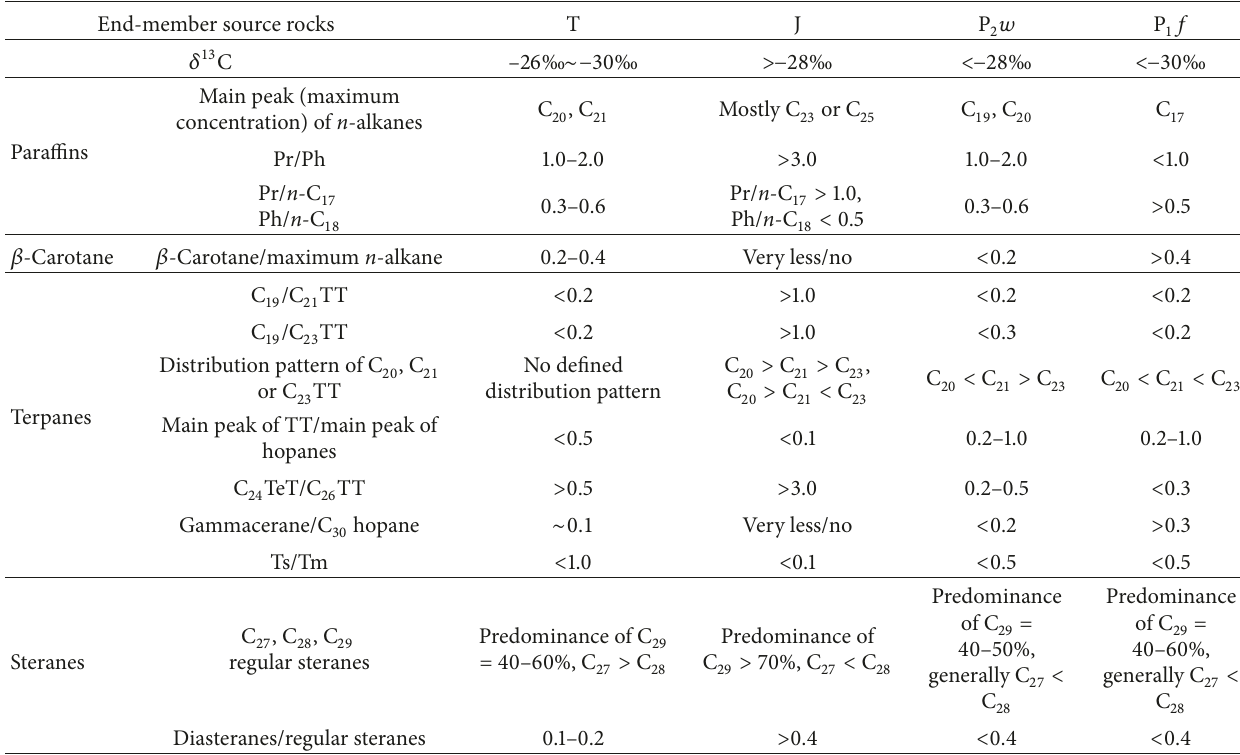
Table 4: Key geochemical differences between Triassic mudstone source rocks and other three identified end-member source rocks (i.e., Jurassic and Permian) in the central Junggar